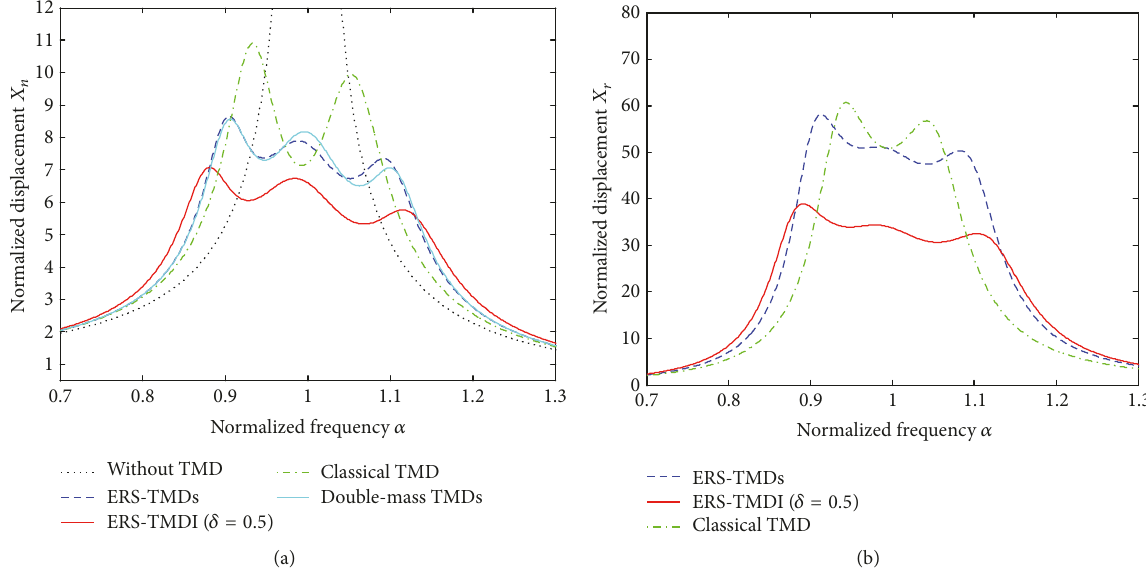
Figure 4: Schematic of the optimal frequency responses for types of SDOF system, where the mass ratio 𝜇 = 0.02 . (a) The frequency response of the deformation of the primary structure and (b) the relative deformation of different buildings.